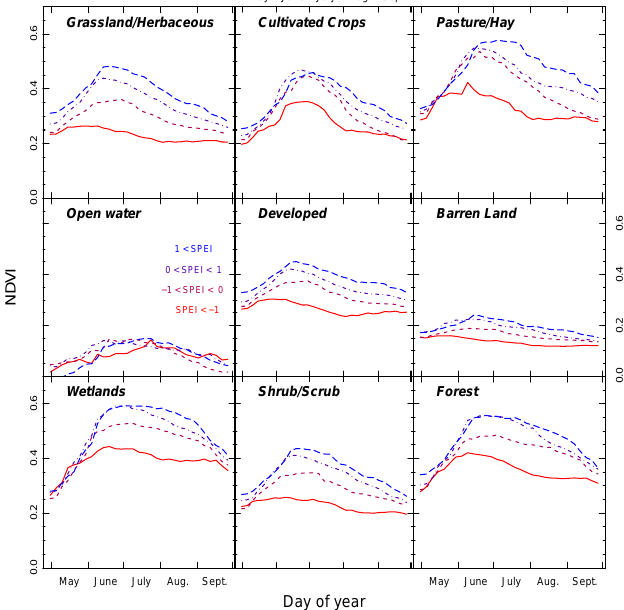
Figure 8. Similar to Figure 7, NDVI is shown to provide context to aid in the interpretation of reflectance. Patterns in this figure are roughly inverse of red